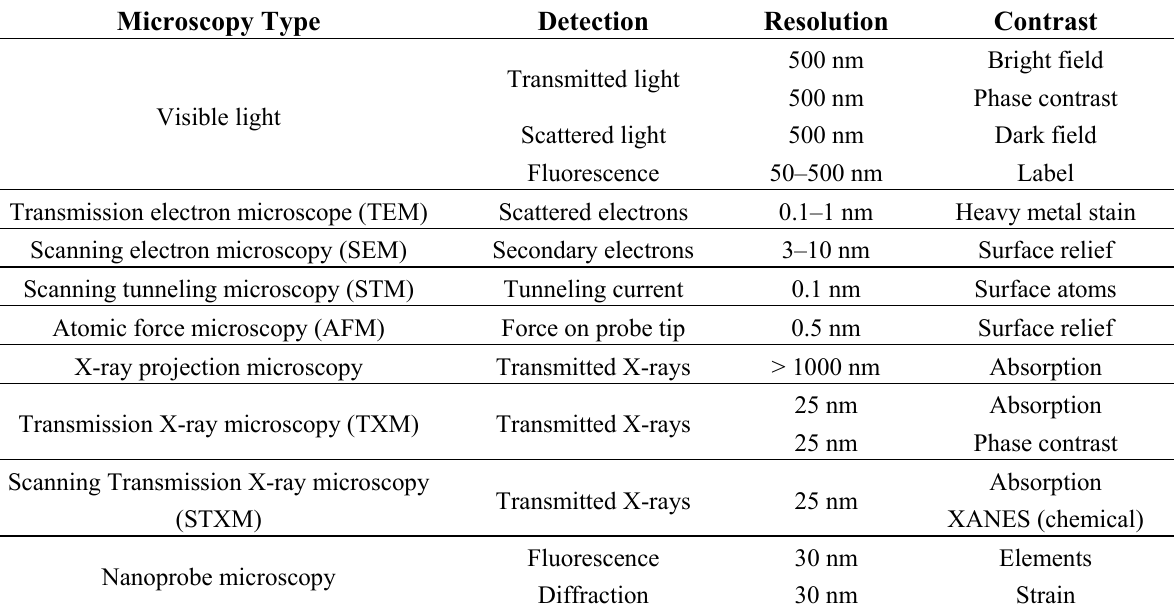
Table 1. Microscopy technologies and their properties [23]. Adapted by permission from Xradia